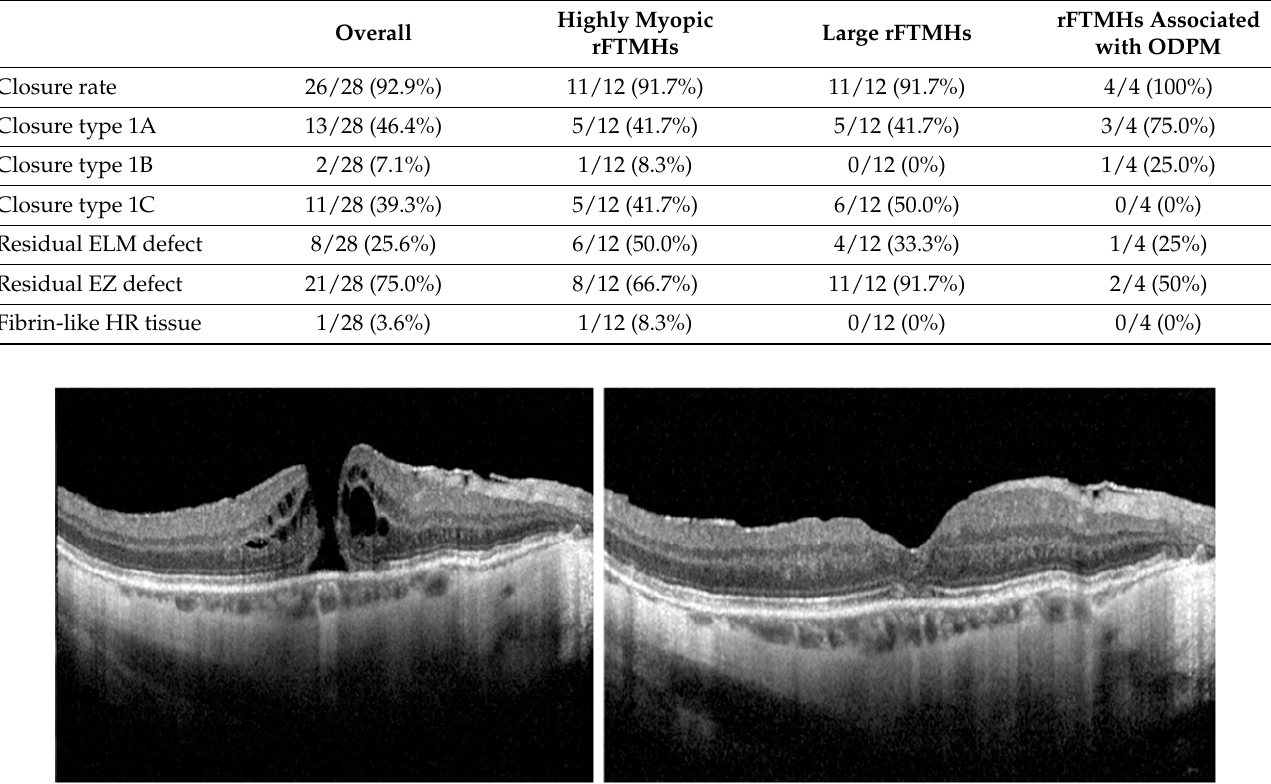
Table 2. The optical coherence tomography data at 6-month follow-up.